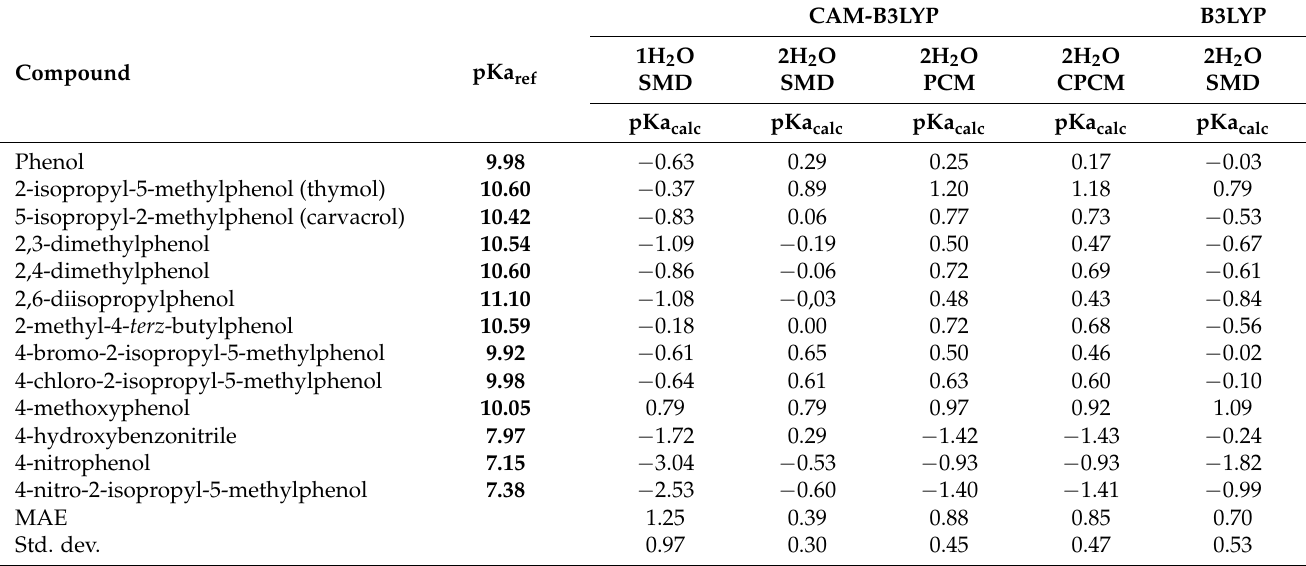
Table 5. ∆ pKa for phenol derivatives with 6-311G+dp basis